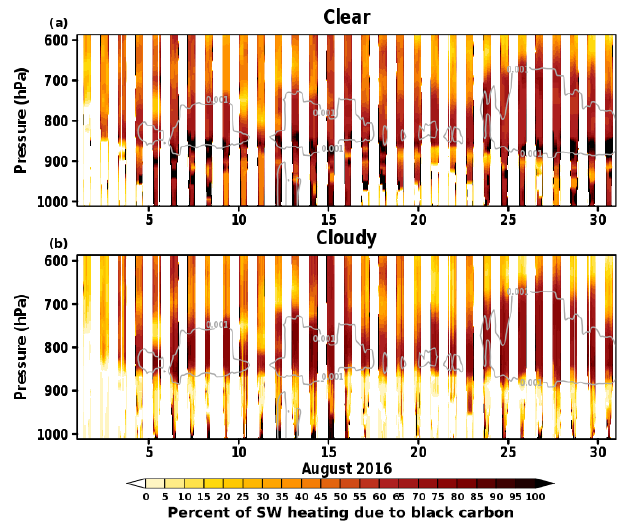
Figure 10. Percent of total SW heating due to black carbon under (a) clear and (b) cloudy skies over Ascension Island during August 2016 using the SSA scaled by relative humidity. Gray contours in- dicate an AOD of 0.001 at 1µm for black